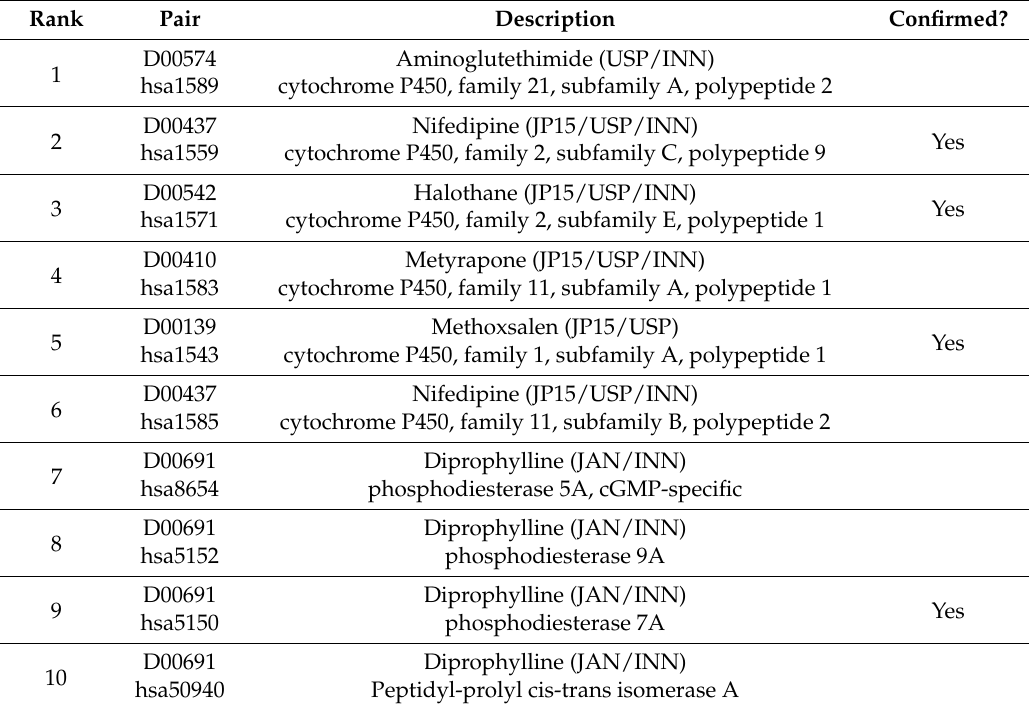
Table 4. The top 10 new predicted interactions on the Es dataset.